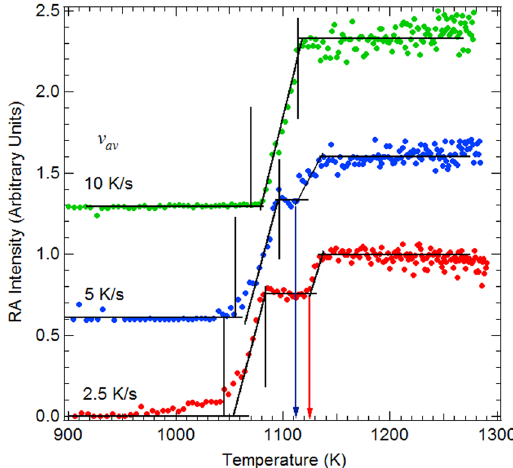
Figure 5. RA intensity versus temperature curves, for three temperature schedules. The curves are given a vertical offset for the sake of clarity. The desorption temperature intervals (95-5% of the Si 4 + intensity) are indicated by the vertical lines. The 7 × 7 DAS to “1 × 1” transition temperature is indicated by a red (blue) arrow for v equal to 2.5 Ks − 1 (5 Ks − 1 av